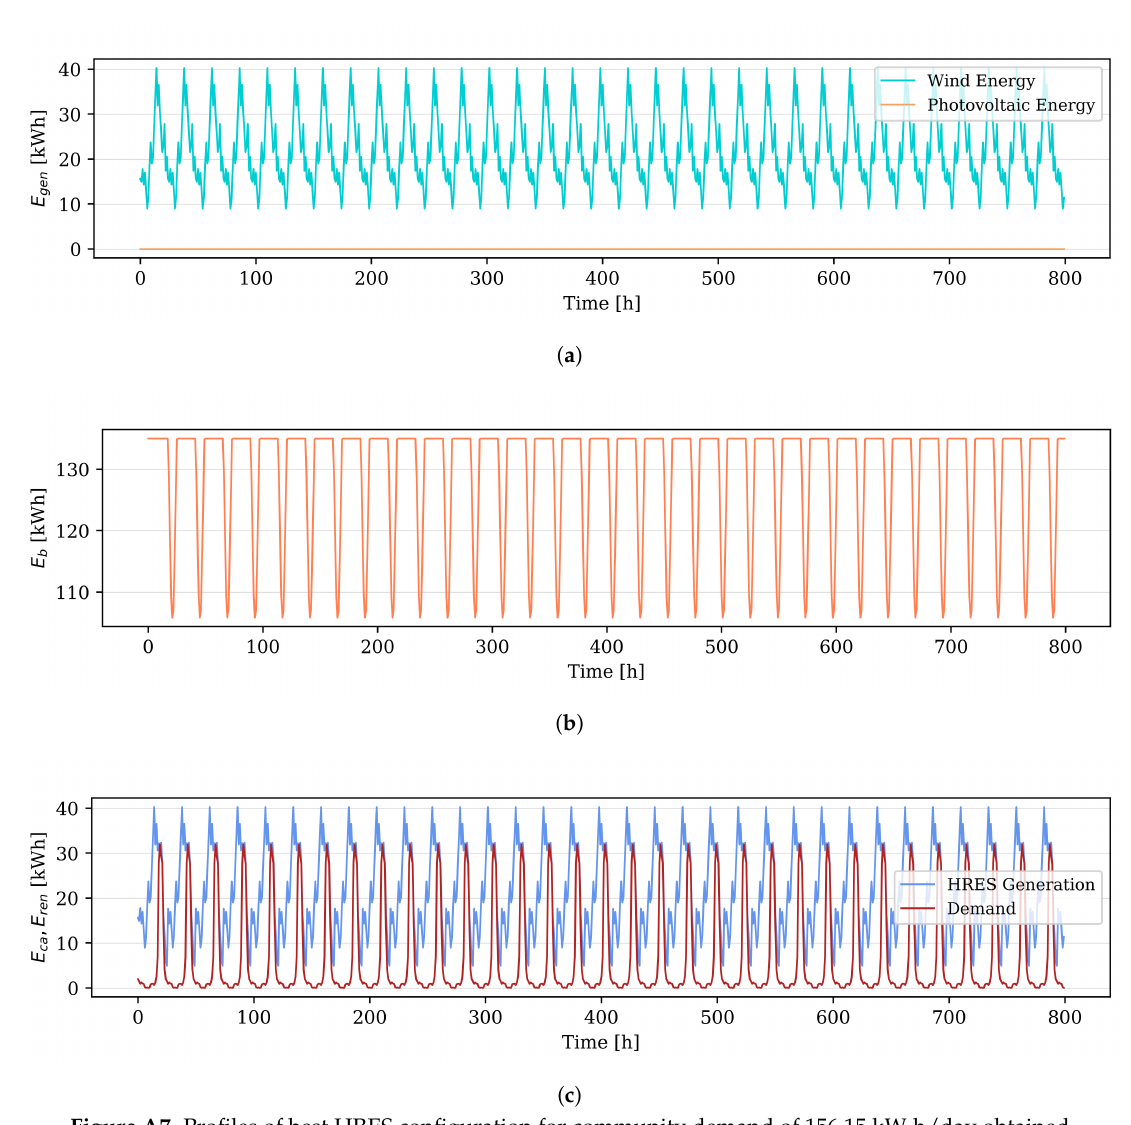
Figure A7. Profiles of best HRES configuration for community demand of 156.15 kW-h/day obtained by single-objective function LPSP , N wt ,1 = 13, N wt ,2 = 13, N wt ,3 = 16, N b = 100. ( a ) Total renewable energy generation. ( b ) Storage system state. ( c ) HRES generation vs.